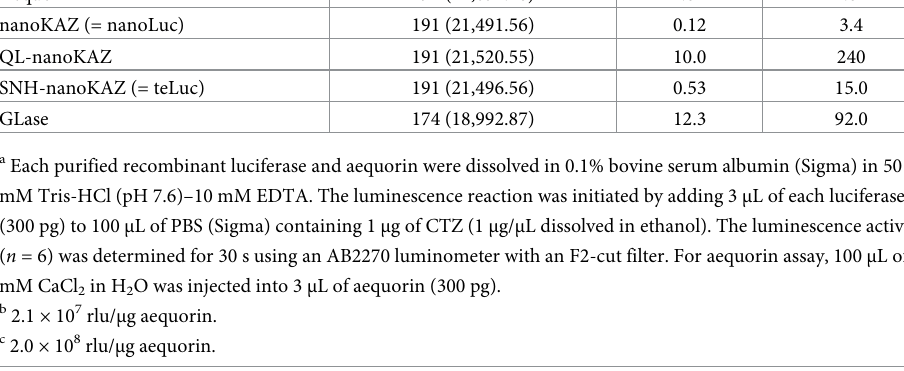
Table 3. Comparison of luminescence activity of QL-nanoKAZ with other CTZ-utilizing luciferases using aequorin as a light standard. Photoprotein or